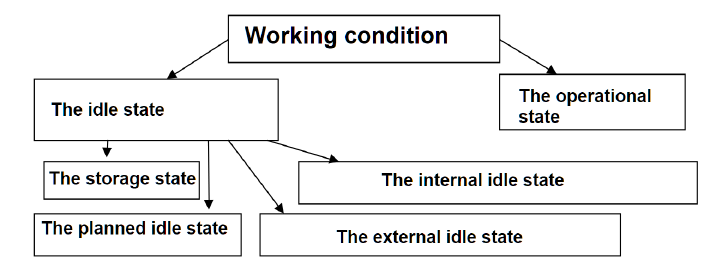
Figure 4. Classification of aircraft